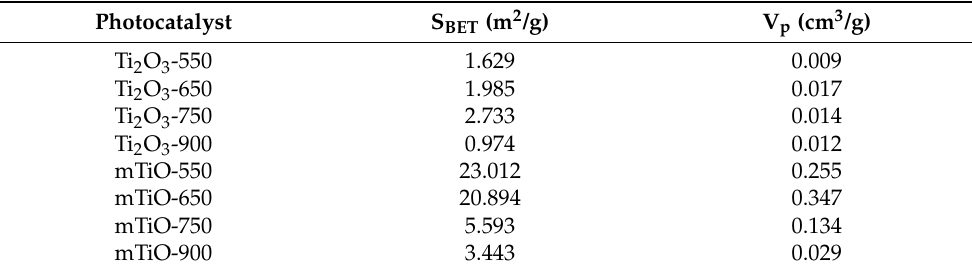
Table 1. BET surface area and pore volume of as-prepared